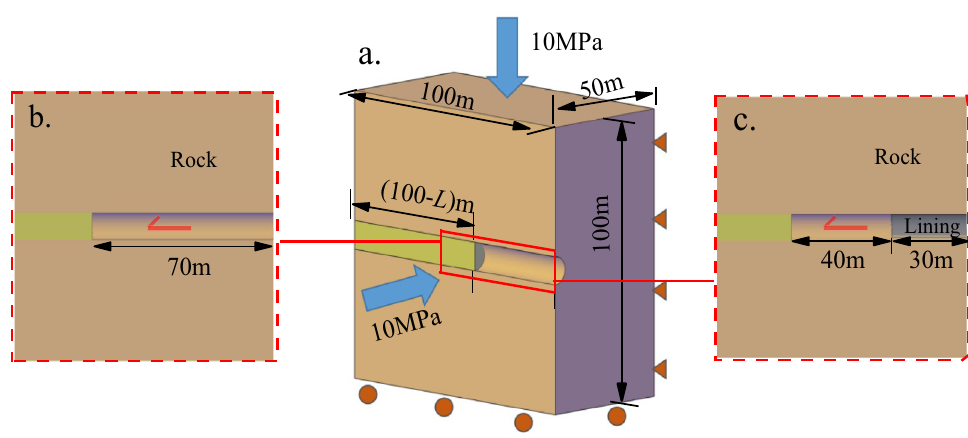
Figure 1. Characteristics of the support constraint effect.